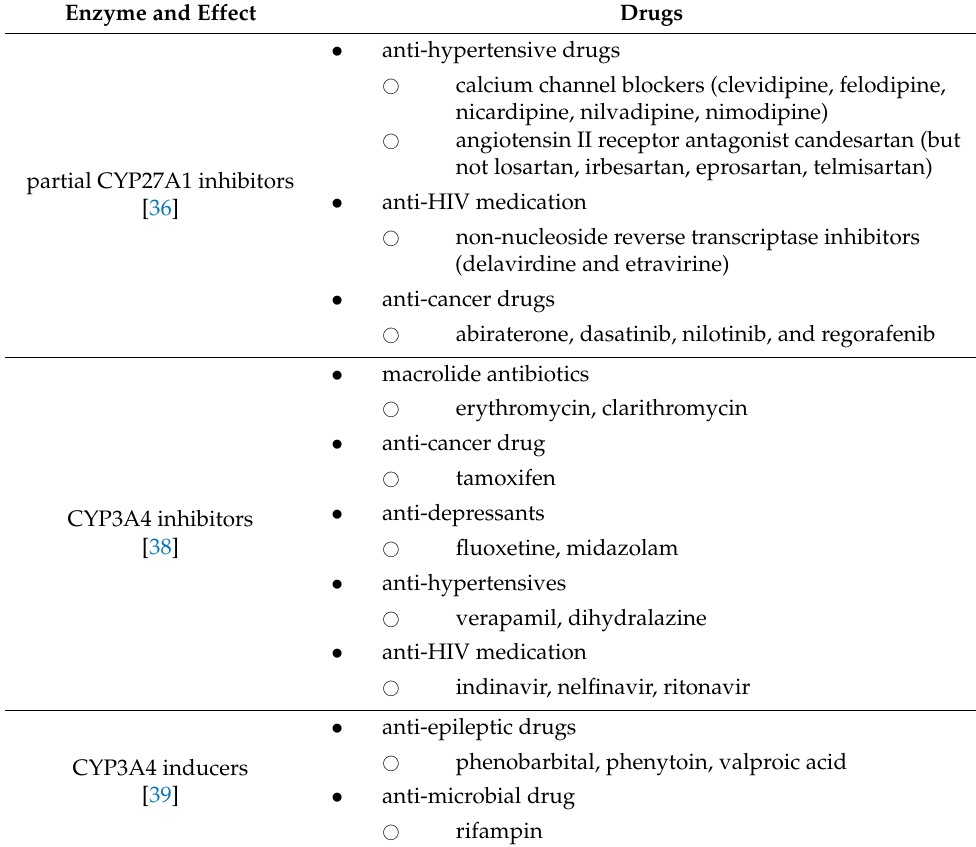
Table 2. Summary of different inhibitors and inducers that affect the enzymes of the cytochrome P450